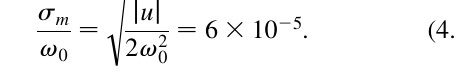
FIG. 5. For LCLS, we plot the rms pulse duration (cid:1) number of modes M with rms bandpass (cid:1) SASE gain bandwidth is taken to be (cid:1) is the value (equal to the Pierce parameter) expected near